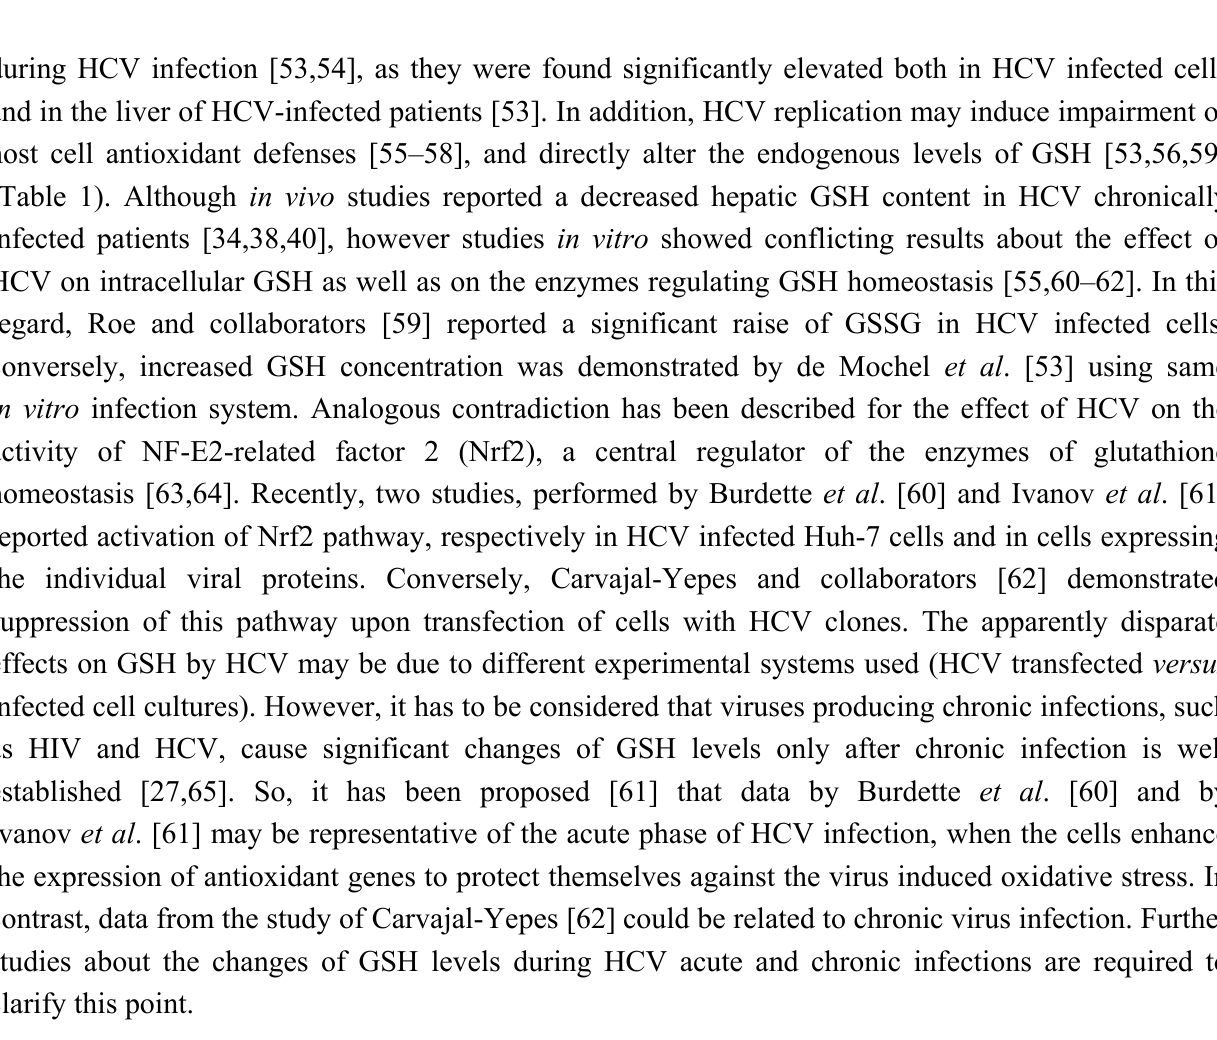
Figure 1. Schematic representation of ROS sources during Hepatitis C virus (HCV) infection and redox mechanisms for activation of MAPKs and